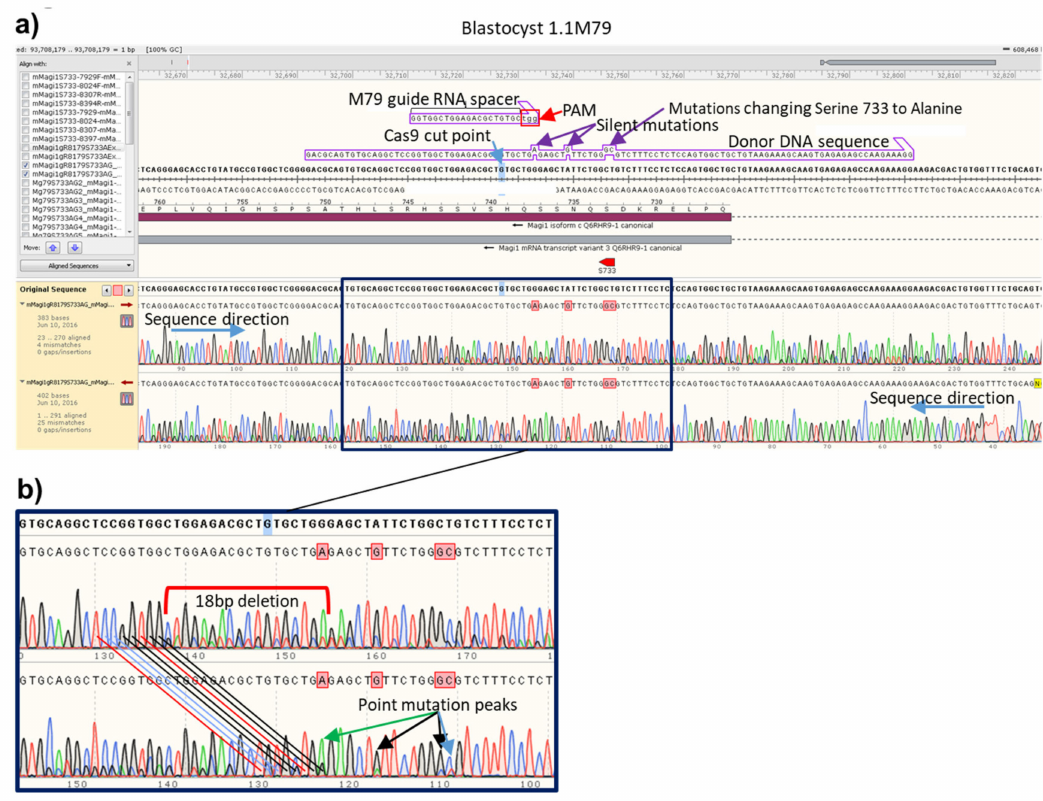
Figure 3. Example Sanger sequence chromatogram from a single mouse blastocyst after CRISPR treatment. Zygotes were injected with Cas9 protein, sgRNA (targeted to the Magi1 gene), and donor DNA (to generate the point mutations leading to S733A, and containing silent mutations to alter the PAM sequence and improve incorporation of the desired mutations). The targeted region was sequenced and analyzed. ( a ) Chromatograms (http: // www.snapgene.com / ) from a single blastocyst (1.1M79) using primers in each direction and aligned to the WT sequence. The guide RNA spacer is the ~20 bp variable region of the guide that matches the DNA sequence adjacent to the PAM. Note the smaller peaks in the sequences after the Cas9 cut point. ( b ) The identity of the single peaks seen upstream of the Cas9 cut point can be matched to the smaller, extra peak seen after the cut point, shifted by 18bp in the reverse direction. These smaller peaks represent the 18 bp indel which existed in about 18% of the chromosome copies in this blastocyst. About 77% of this blastocyst’s chromosomes contained the desired point mutations. If the nucleotide indicated by the major peak in a Sanger sequence does not match the sequence it is being compared to, the SnapGene program used here to generate this image labels it in pink. In this case, the blastocyst’s sequences are being compared to the WT